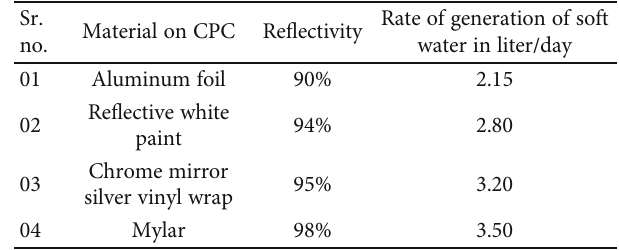
Figure 11: Variations of the rate of generation and measuring temperatures versus time (Mylar). Table 6: Various materials used on CPC with re fl ectivity and rate of generation of soft